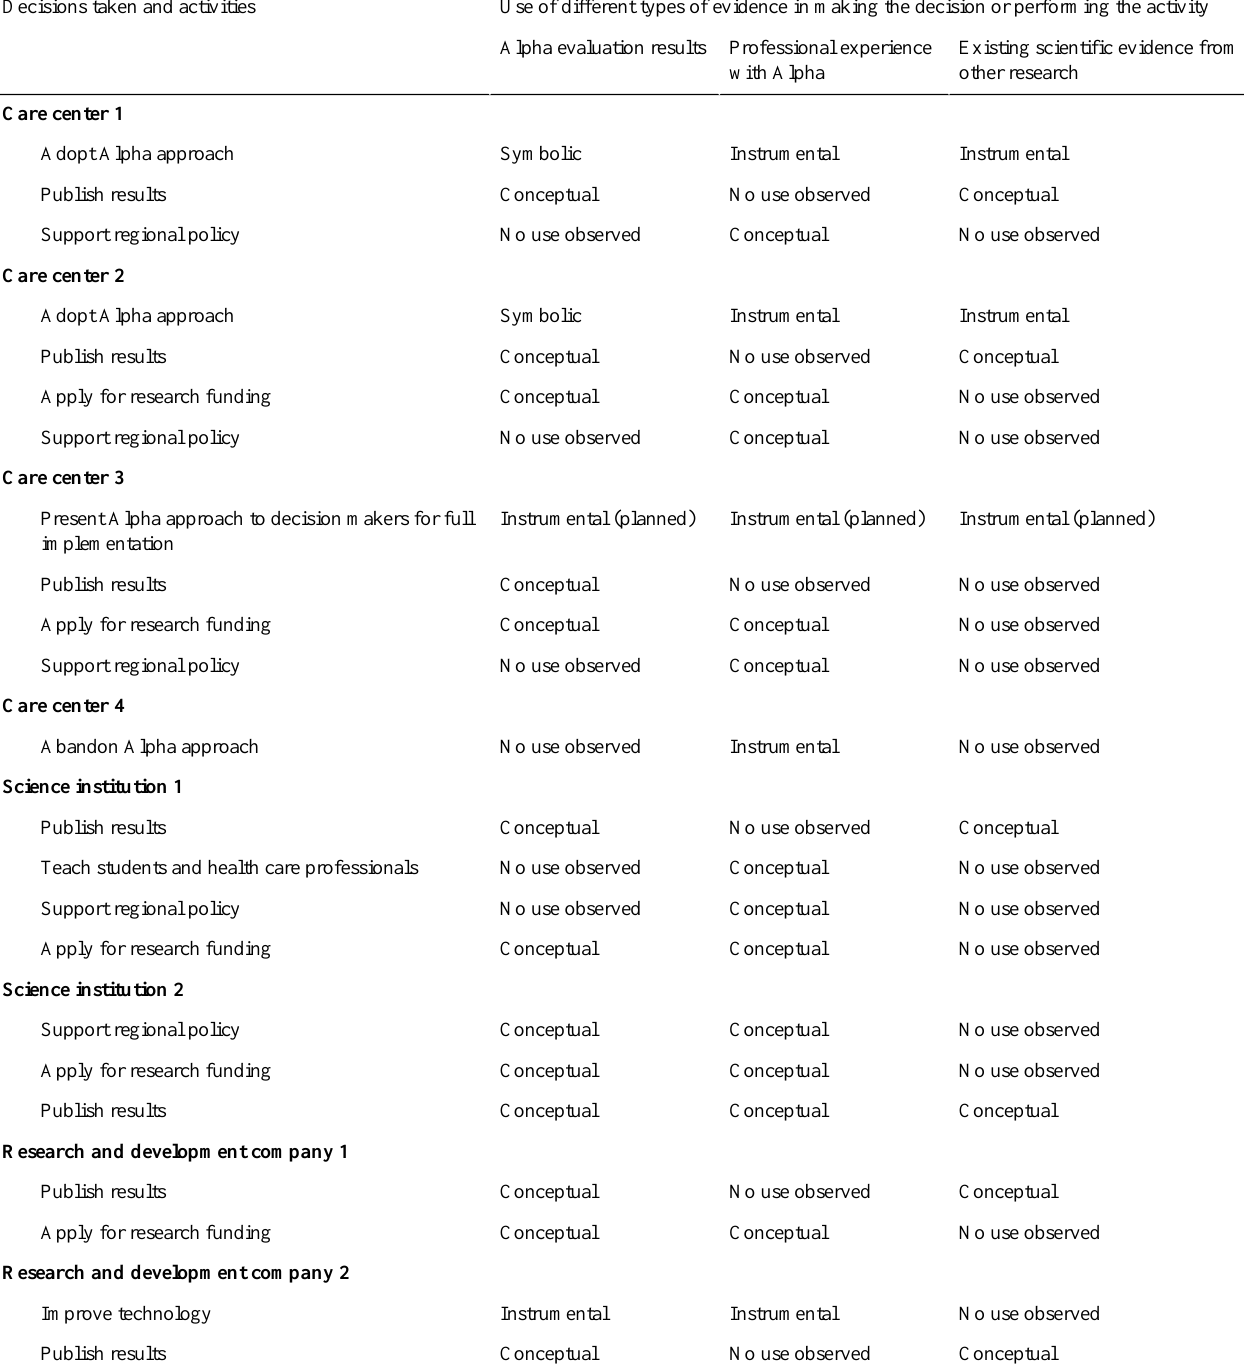
Use of different types of evidence in making the decision or performing the activityDecisions taken and activities